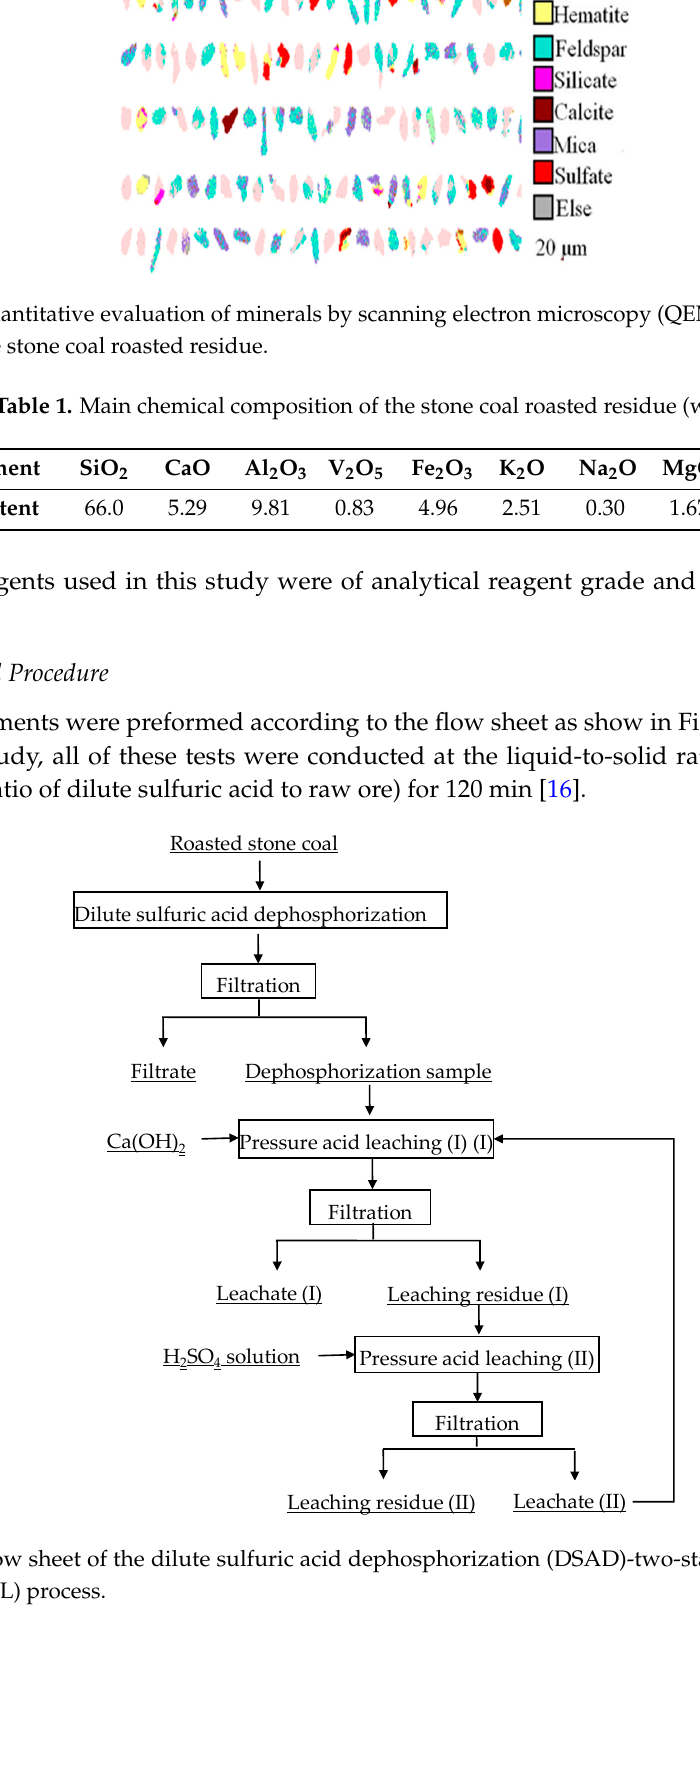
Table 1. Main chemical composition of the stone coal roasted residue (wt %).